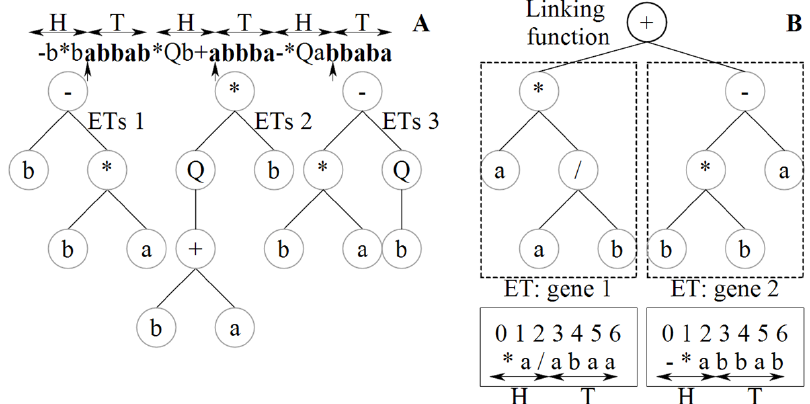
Figure 4. ETs expression and coded chromosome for ( A ) three and ( B ) two genes denoting the head ( H ) and tail ( T ). The vertical arrow corresponding to bolded characters show the termination point of each gene ( A ).